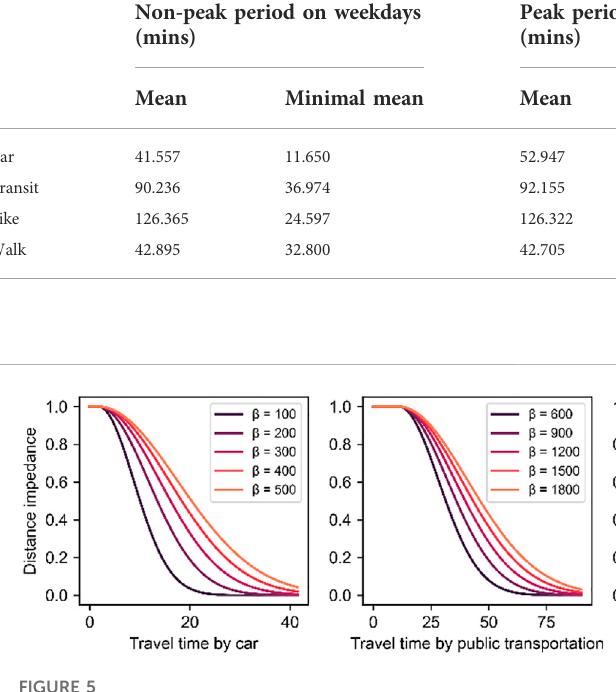
FIGURE 5 Patterns of distance decay of travel